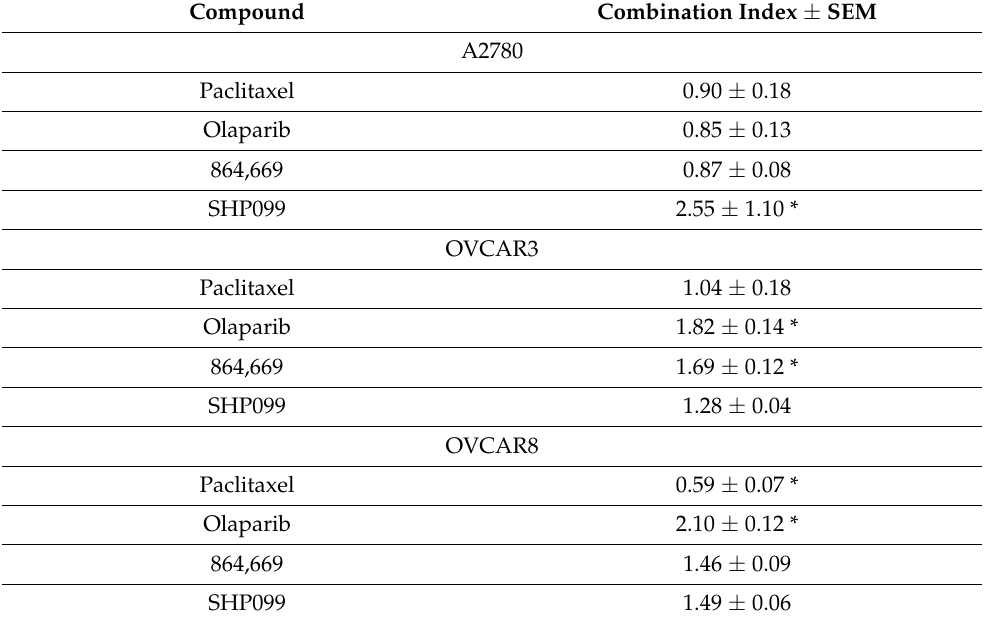
Table 2. Compound combinations in human OvCa cells. Combination Index (CI) was measured with EC 50 concentrations of each compound. The single agent EC 50 values for A2780, OVCAR3 and OVCAR8 cells in these studies were: JMS-053: 3, 5 and, 10 µ M; paclitaxel: 0.04, 60 and 10 µ M; olaparib: 50, 90, 70 µ M; 864,669: 7, 70, 30 µ M; SHP099: 0.5, 60, 30 µ M. N = 3. Unpaired Student’s t -test compared to JMS-053 alone. * p <